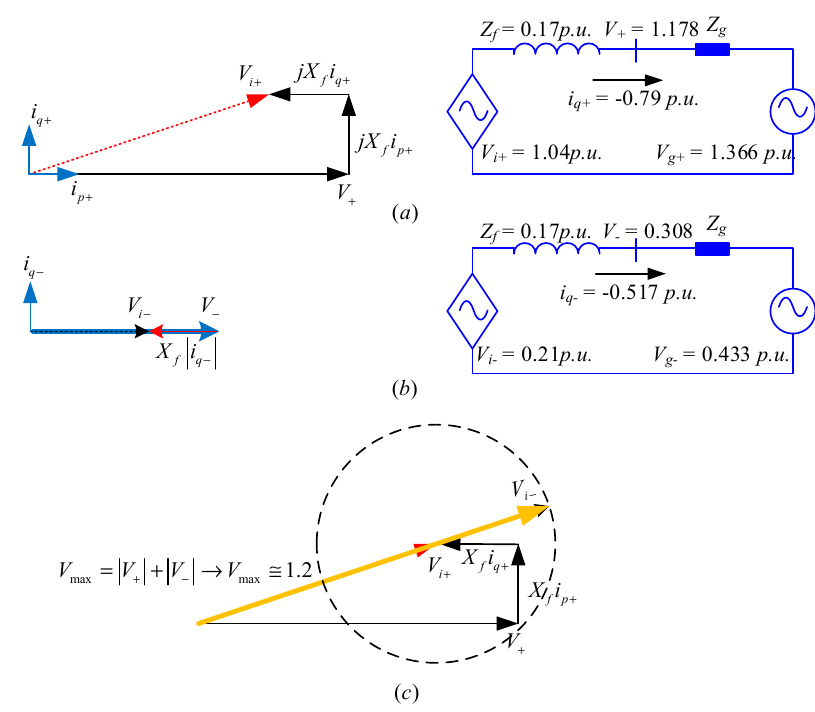
Figure 8. Vector representation of voltages and currents of GC-VSC for voltage swell. ( a ) Positive sequence. ( b ) Negative sequence. ( c ) Inverter voltage in the worst case.